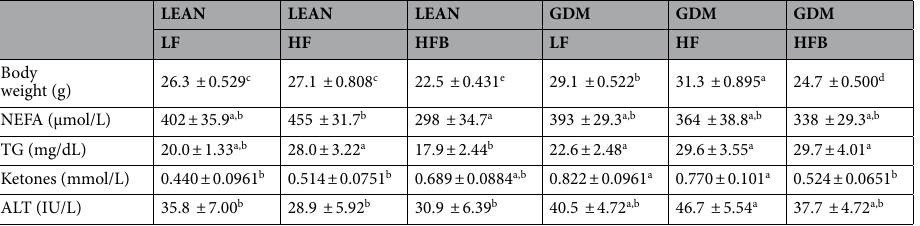
Table 2. Characteristics of offspring. All measurements were obtained following 12-weeks of the indicated diet (LF, HF, HFB). Values are means ± SEMs (n = 5–15), means without a common letter differ, p < 0.05. NEFA non-esterified fatty acids, ALT alanine